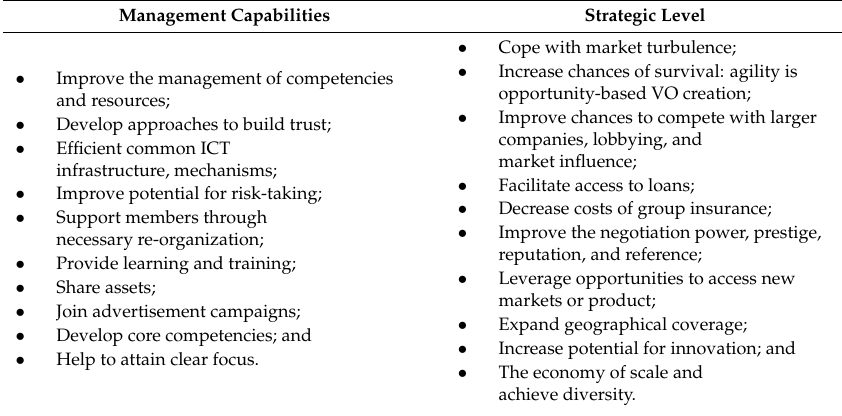
Table 3. Motivations to Participate in a Virtual Organizations Breeding Environment (VBE).